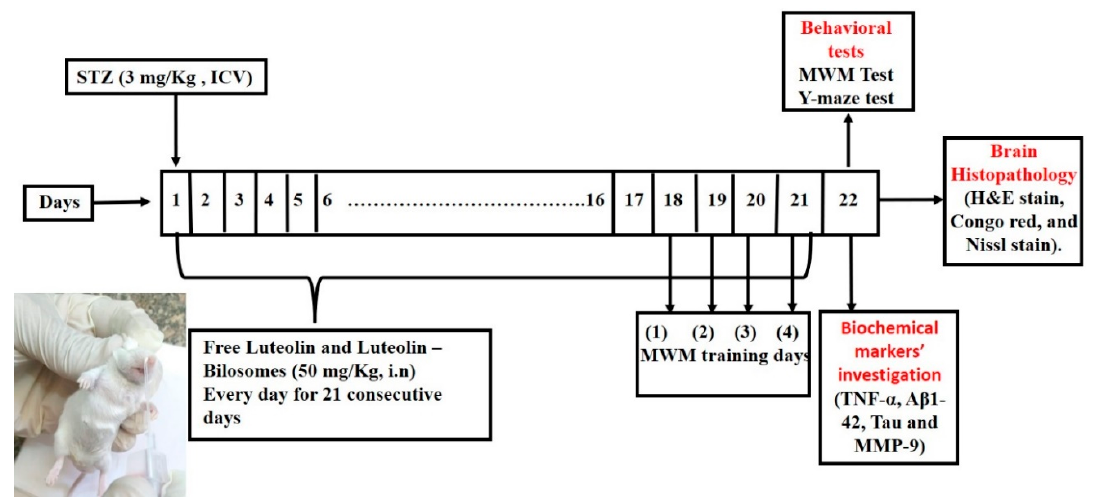
Figure 1. A schematic representation of the in vivo experimental design .